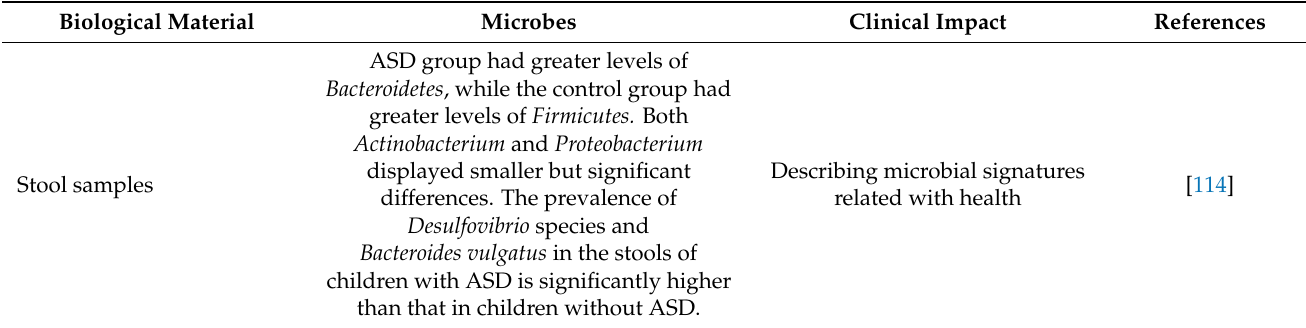
Table 2. Gut microbiota in children and adolescents with